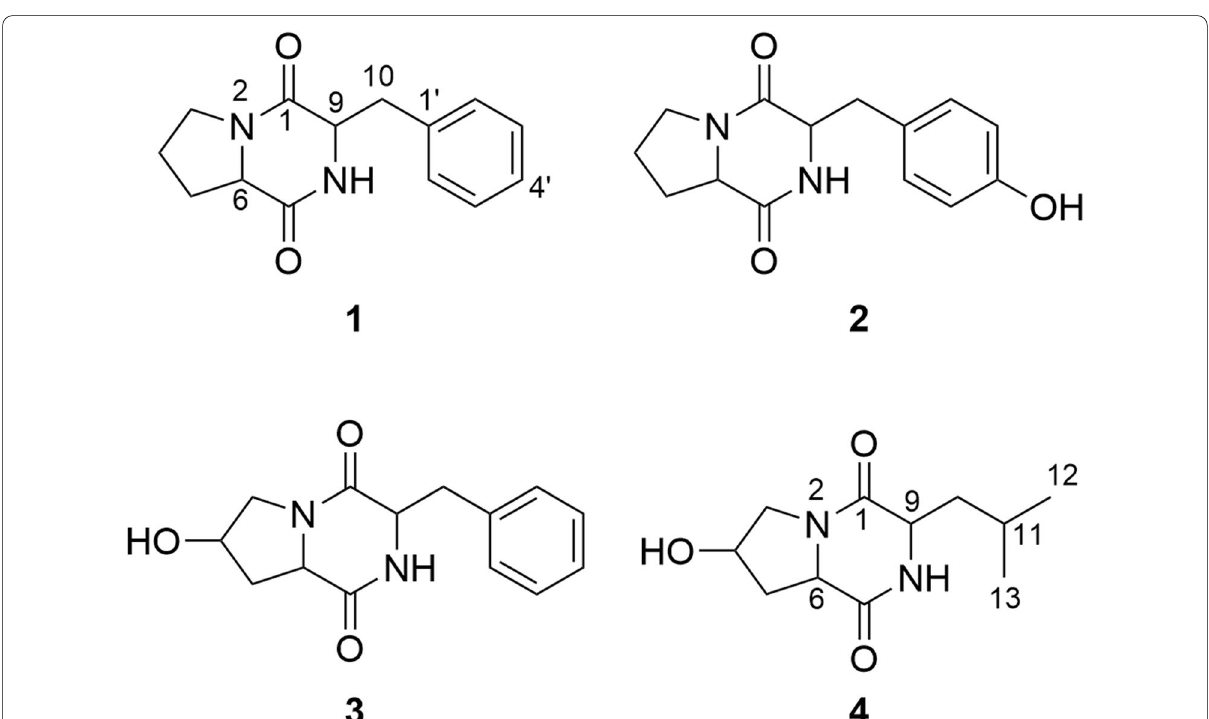
Fig. 4 Chemical structures of compounds 1 –